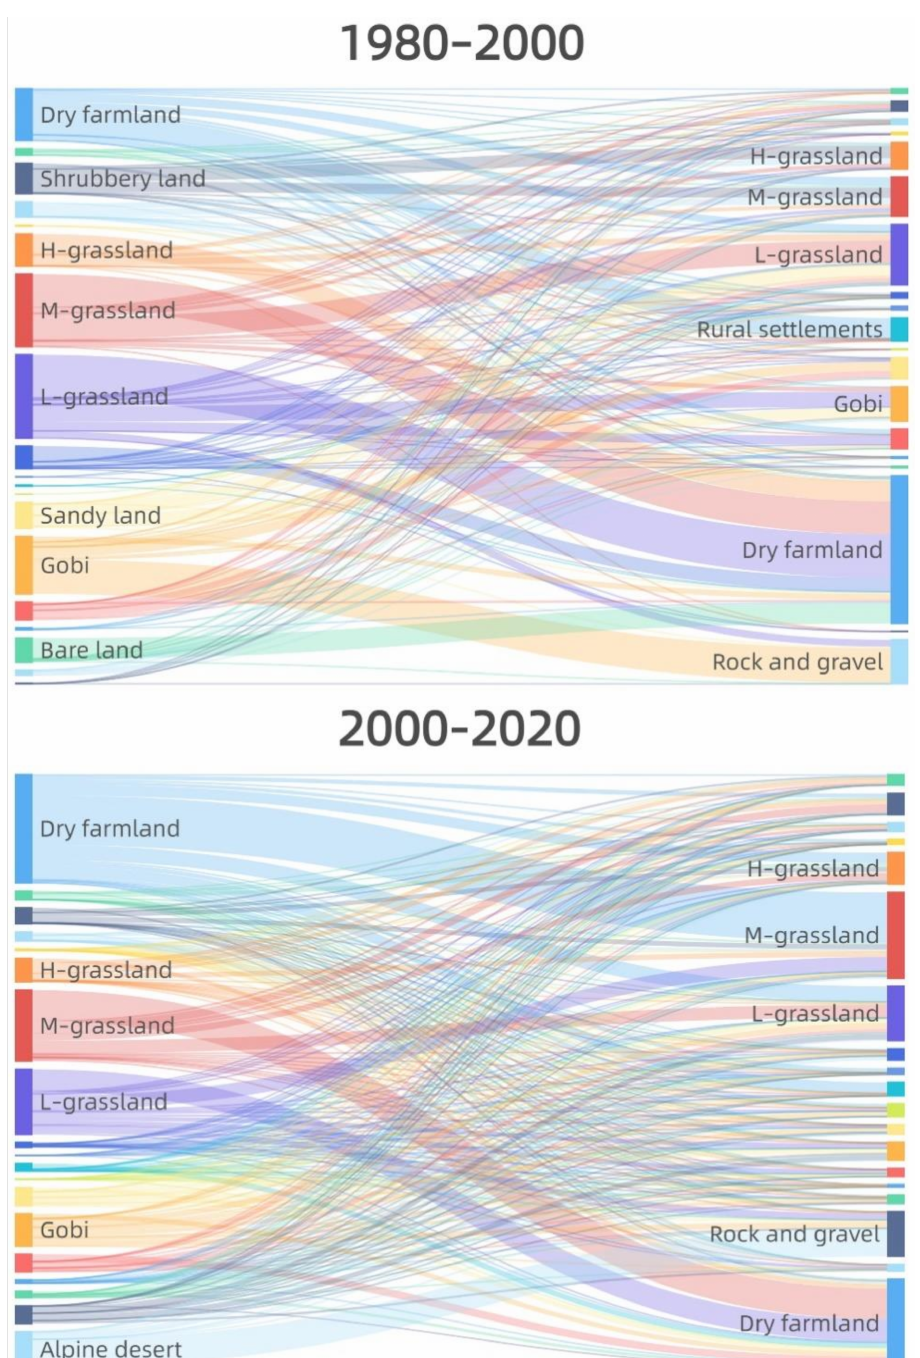
Figure 4. LUTC Sankey diagram of Gansu in 1980–2000 and 2000–2020.